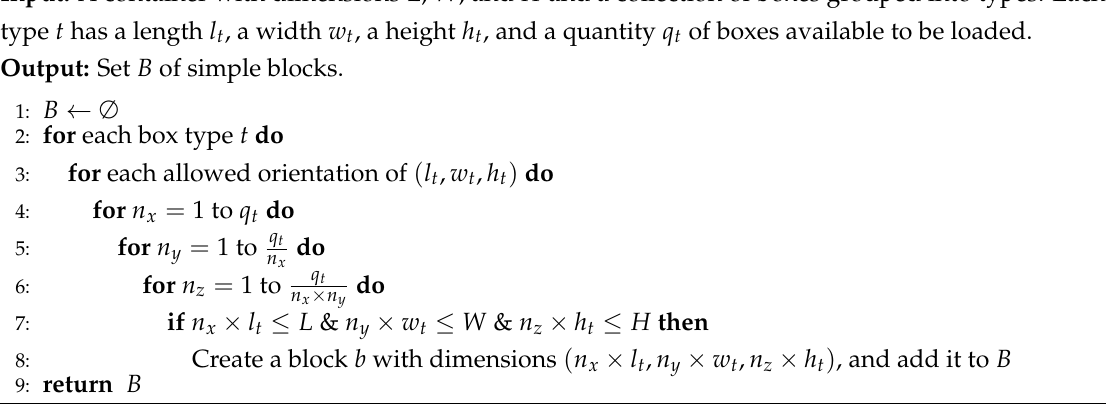
Algorithm 1 Generating simple blocks (adapted from the original paper